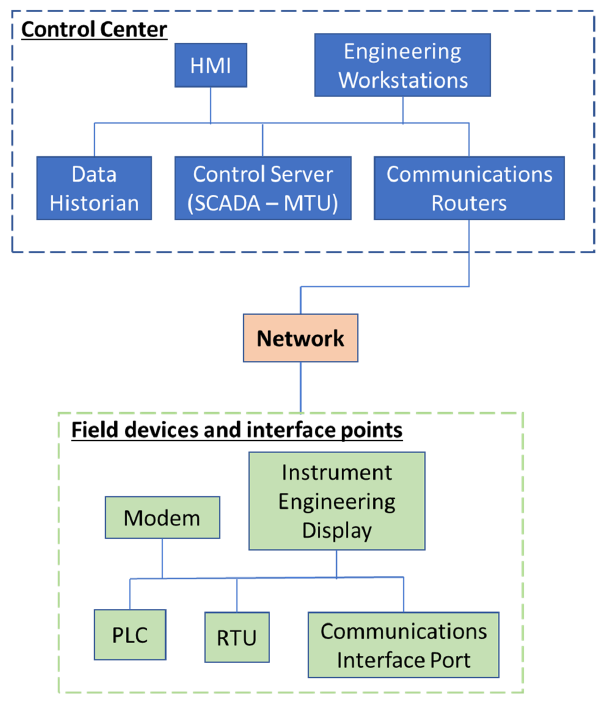
Figure 5. Vessel’s ICS communication data flow.